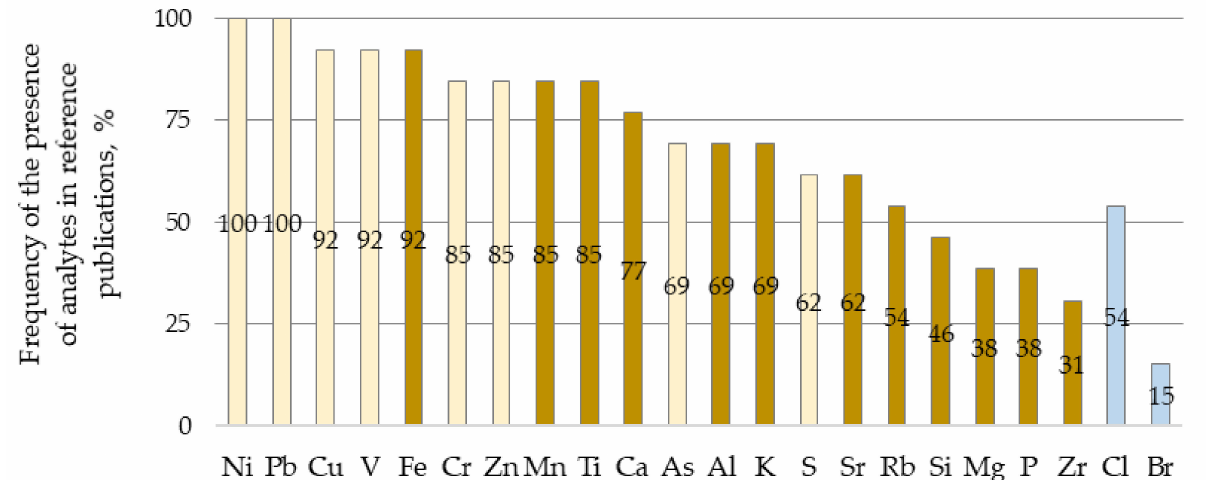
Figure 6. Frequency of the presence of analytes in reference publications. PHEs are indicated in yellow, crustal elements in brown, halogens in